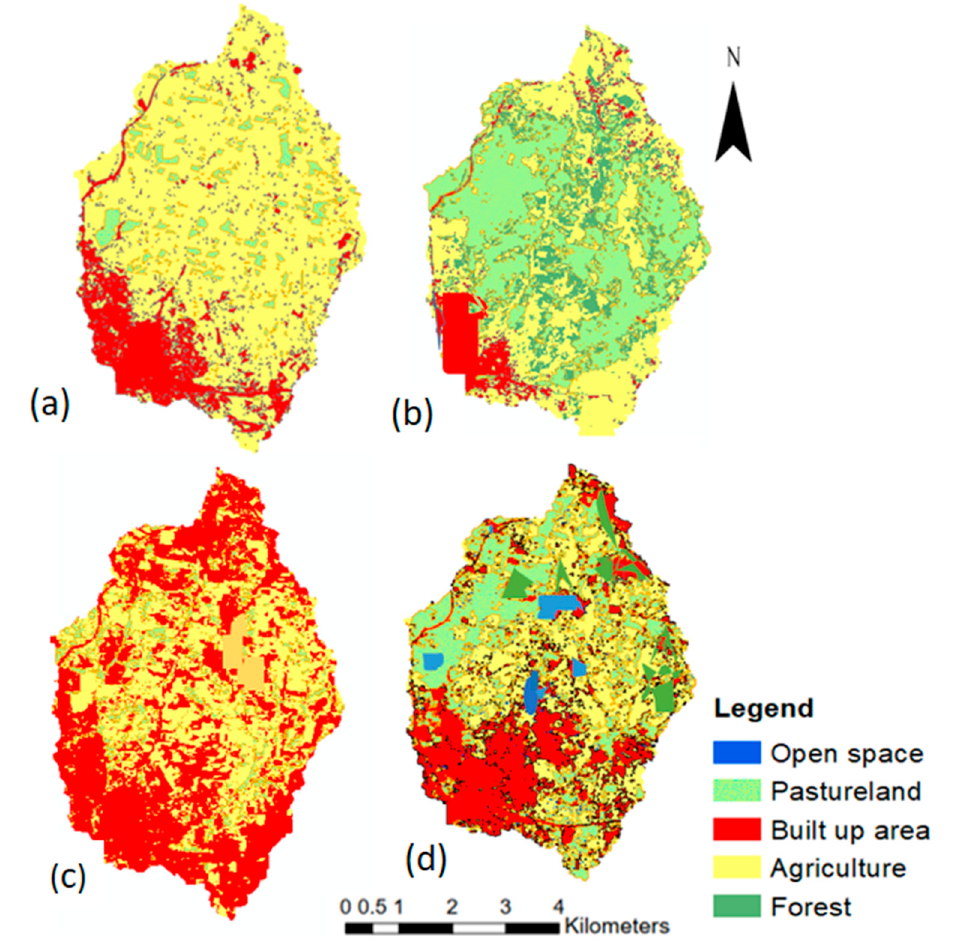
Figure 2. Projected LULC scenarios of Kakia and Esamburmbur sub-catchments: ( a ) scenario 1; ( b ) scenario 2; ( c ) scenario 3; ( d ) scenario 4.